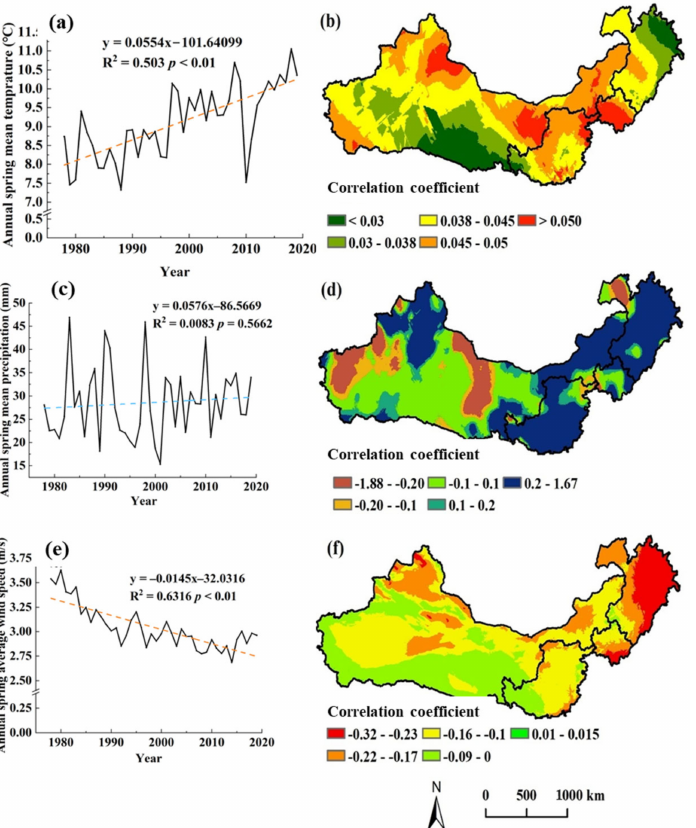
Figure 7. Dynamic change in the climate changes in the TNR of China from 1981 to 2020. ( a ) Temporal change and ( b ) spatial pattern change in mean temperature; ( c ) temporal change and ( d ) spatial pattern change in precipitation; ( e ) temporal change and ( f ) spatial pattern change in mean wind